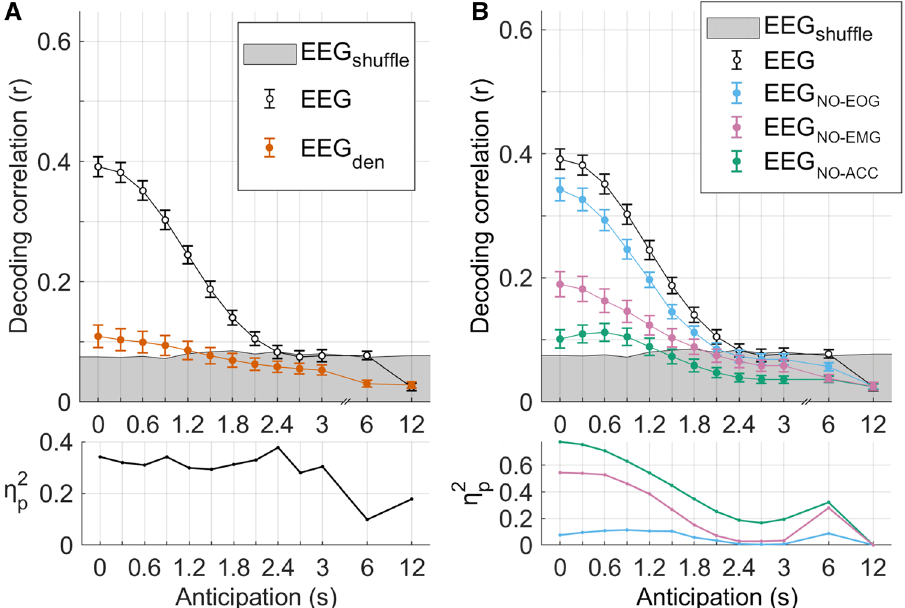
Figure 4. Disentangling cortical signals contribution to steering decoding. ( A ) Steering decoding correlations using EEG data with progressively longer anticipation, with the LLR window set to 1.5 s. Results indicate decoding correlations when using the EEG before and after removing motion-related components (EEG and EEGden respectively). Error-bars indicate the SD across participants. The grey shaded area indicates the baseline prediction correlation (95 th percentile of the null distribution). The plot on the bottom reports the effect-size for EEGden > baseline. ( B ) The steering signal was prediction by removing selectively each potential non-brain signal. The LLR window was set at 1.5 s. Error-bars indicate the SD across participants. The grey shaded area indicates the baseline prediction correlation (95th percentile of the null distribution). The plot on the bottom reports the effect-size for EEG > EEG NO-SIGNAL for each signal of